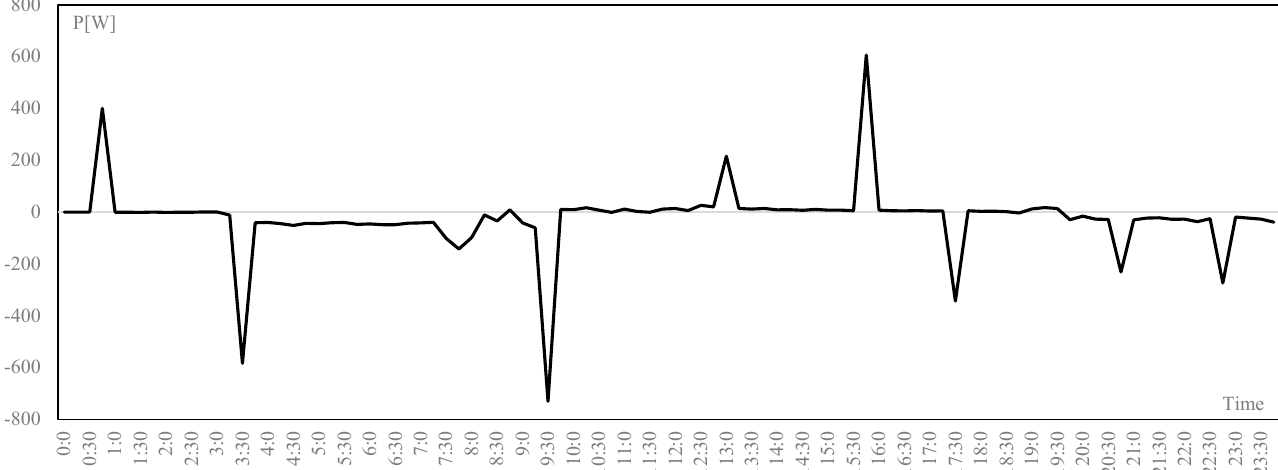
Figure 23. Exchanged net power for the community with flexibility services requests.